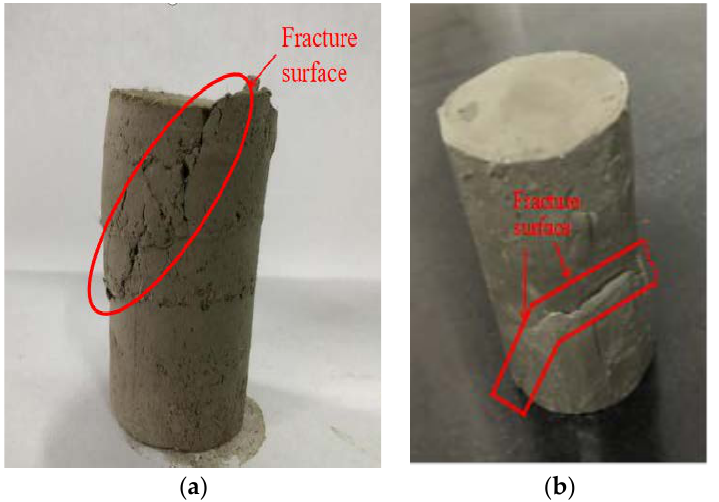
Figure 15. Tensile failure specimen. ( a ) Fiber reinforced specimen, ( b ) specimen without polypropylene fiber.